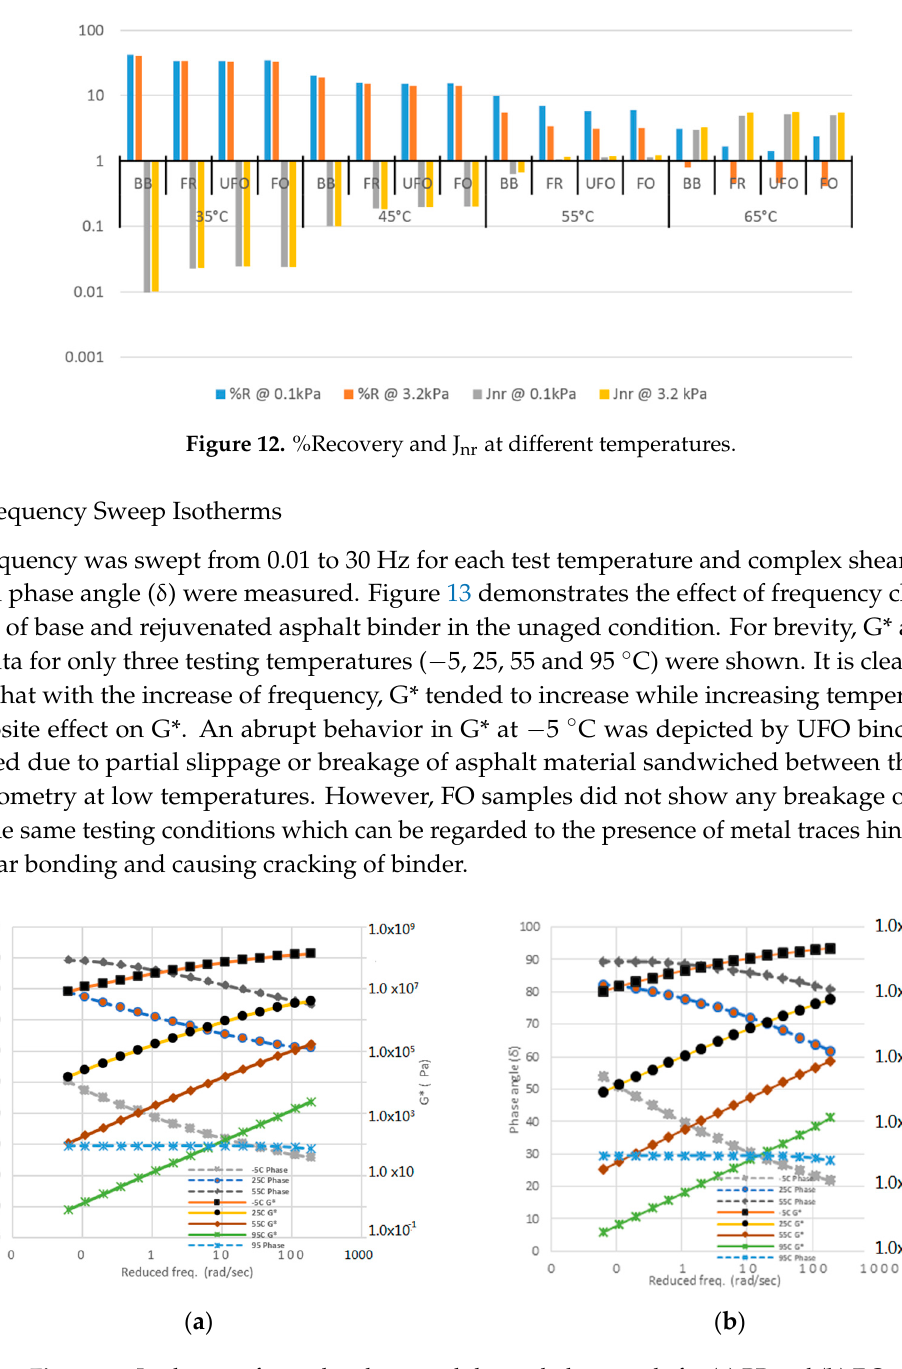
Figure 13. Isotherms of complex shear modulus and phase angle for ( a ) BB and ( b ) F.O.